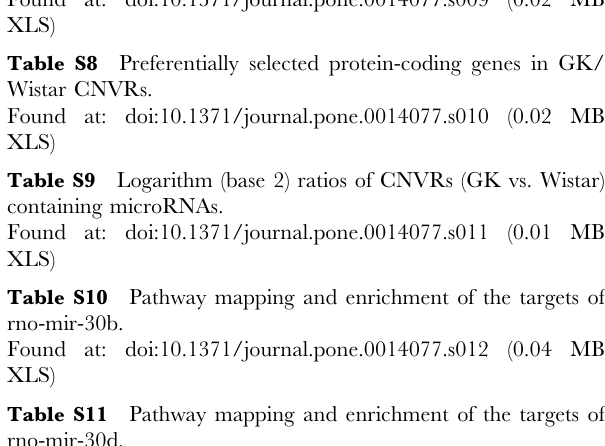
Table S12 Coding signals annotated in sources other than Entrez Gene (EG).